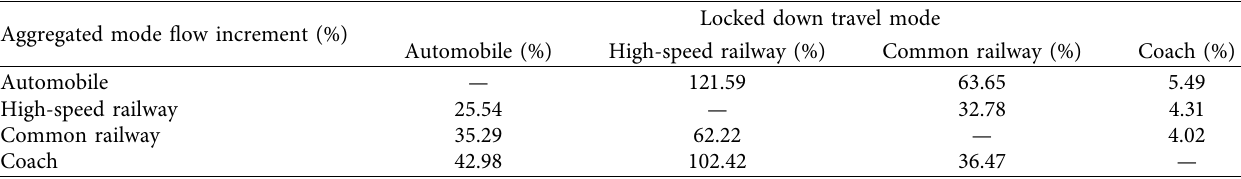
Table 14: Results of the aggregated mode flow increment in percentage under cases applying lockdown on different travel modes for destinations inside Hubei.